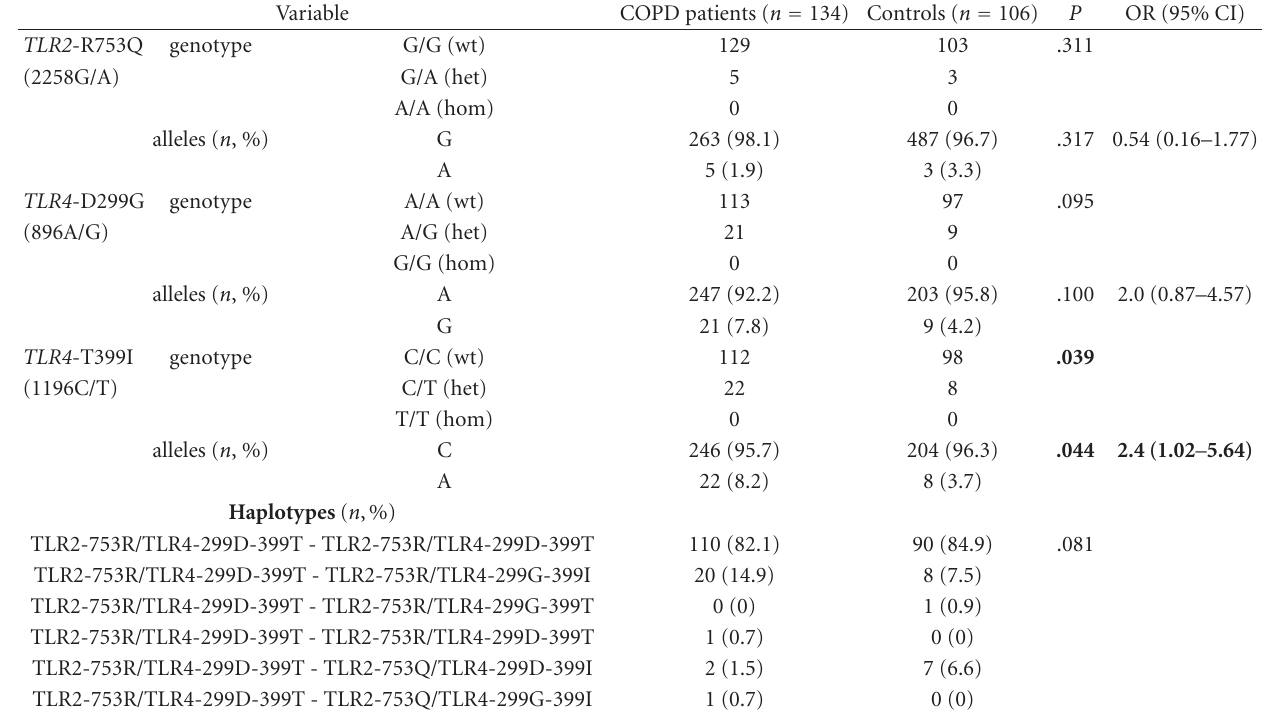
Table 2: Distribution of the TLR SNPs in smokers with and without